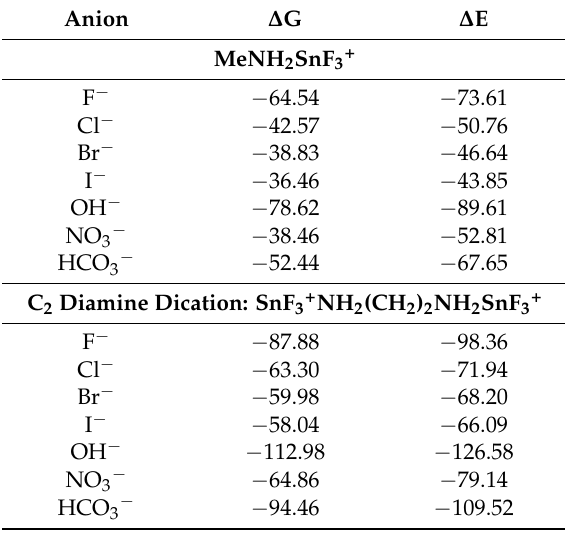
Table 5. Energetics (kcal/mol) for interactions between anions and indicated mono and di-cationic